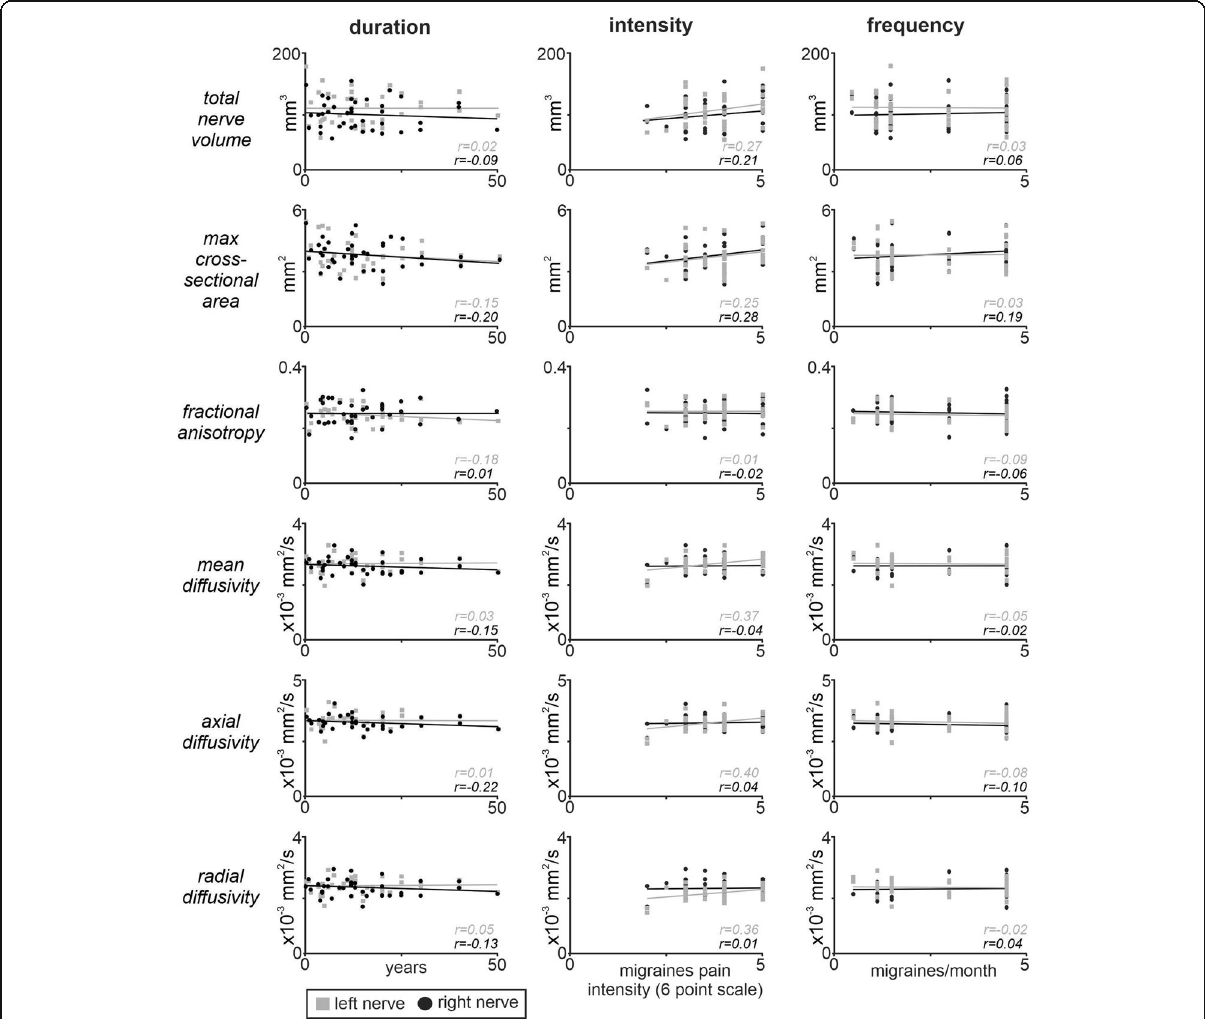
Fig. 3 Plots showing linear relationships between the left (grey shading) and right (black shading) total nerve volume, maximum cross-sectional area, fractional anisotropy, mean diffusivity, axial diffusivity and radial diffusivity in migraineurs with migraine duration, intensity and frequency. Note that there were no significant linear relationships. * p <